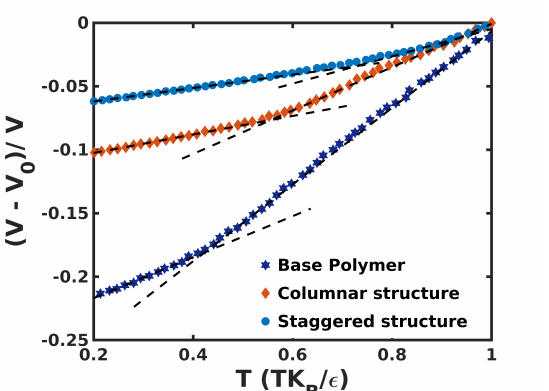
Figure 3. Plot of the system volume as a function of temperature during cooling for the homopolymer and composite systems.